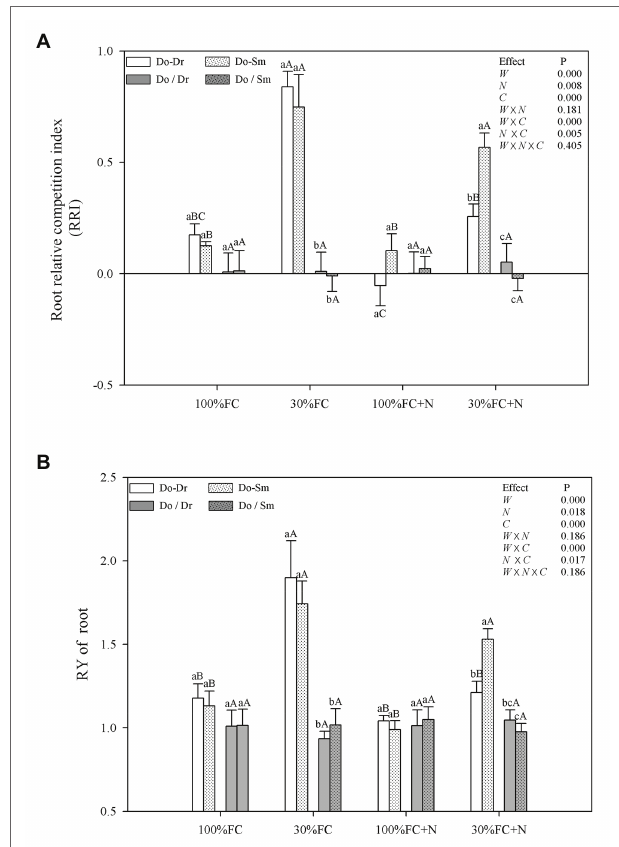
FIGURE 5 | Effects of water, N fertilization levels on RRI (A) and RY of root (B) in different species competition models. Means ± SEs, n = 5. Different lowercases in each graph indicate significant difference among different competitive models (competition between D. odorifera and various N-fixing niche neighbors) under the same water and N application according to Duncan’s tests ( p < 0.05). Different uppercases in each graph indicate significant difference among different water and N fertilization application in the same competitive models according to Duncan’s tests. 100% FC, 100% field capacity; 30% FC, 30% field capacity; 100% FC + N, 100% field capacity and N fertilization; 30% FC + N, 30% field capacity and N fertilization. Do-Dr, Do-Sm indicate D. odorifera planting with D. regia (white bars) and S. mahagoni (white bars with dots) in the root system contact models, respectively; Do/Dr and Do/Sm indicate D. odorifera planting with D. regia (gray bars) and S. mahagoni (gray bars with dots) in the root system isolation models, respectively; W, water factor effect; N, nitrogen factor effect; C, species competition models factor effect; W × N, interaction effect of water and nitrogen factors; W × C, interaction effect of water and species competition models factors; N × C, interaction effect of nitrogen and species competition models factors; W × N × C, interaction effect of water, nitrogen and species competition models factors; Multivariate analysis of variance (Multi-ANOVA) was conducted to evaluate the influence of different factors and their interaction